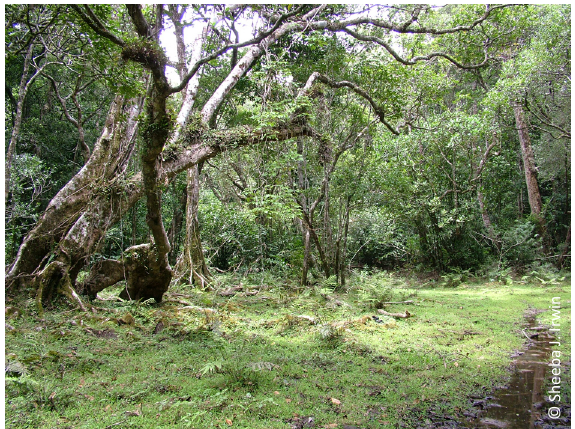
Figure 1. Population sites of Elaeocarpus venustus in Kanyakumari District, Tamil Nadu